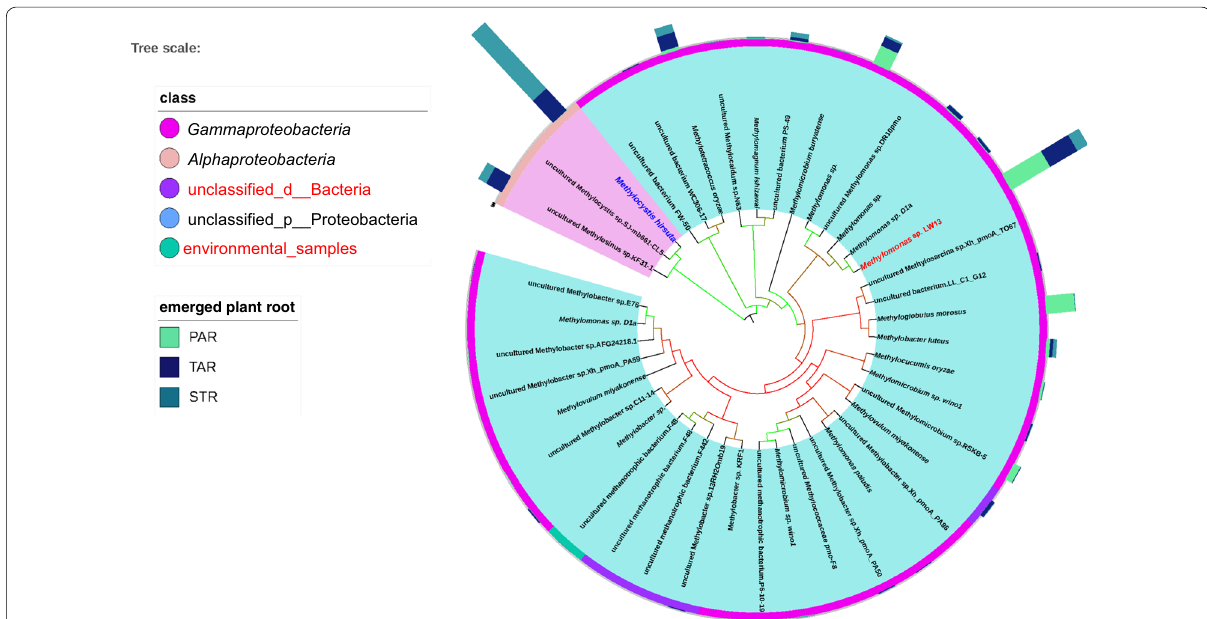
Fig. 4 Neighbor-joining tree of methanotrophic phylotypes detected in the emergent plants based on the cDNA of pmo A genes. The blue part of the inner circle represents type I; the pink part represents type II. The different colors in the outer circle represent the corresponding class of OTU. Multi value bar charts represent the relative abundance of OTU in different plants